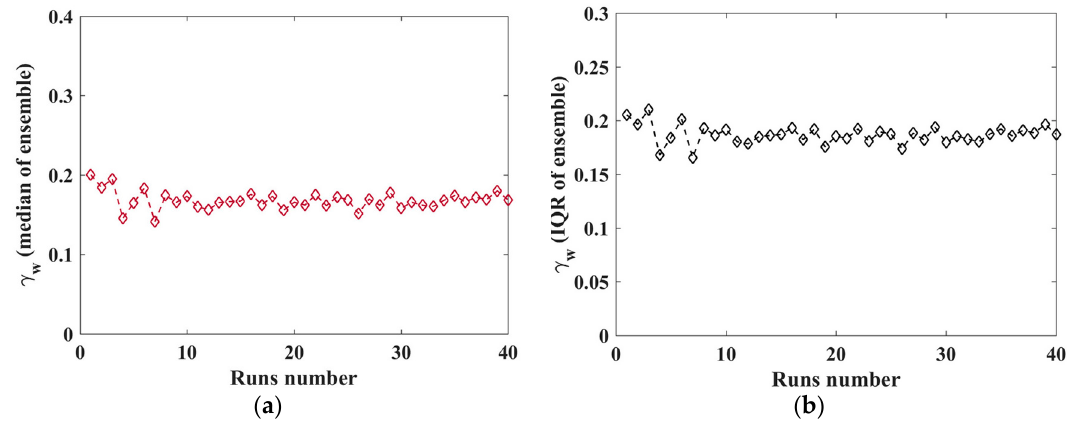
Figure 10. ( a ) Medians; ( b ) inter-quartile range of ensemble γ w calculated over the study area as function of runs number included in the ensemble.